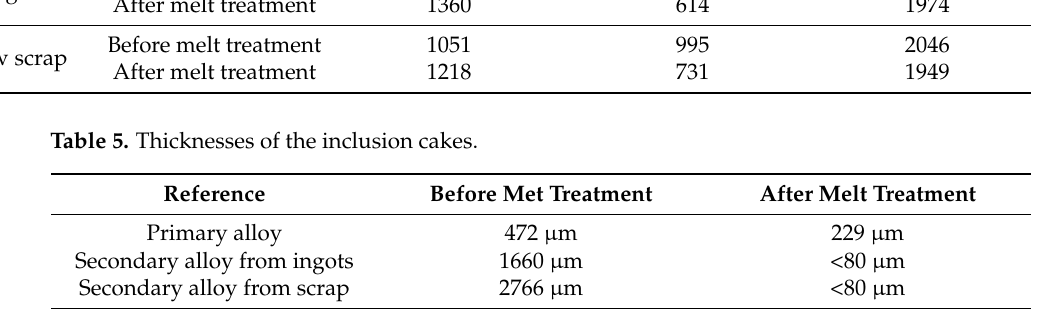
Table 4. The filtered and unfiltered melts during the different trials. The samples were analysed using optical microscopy and SEM, as shown in Figure